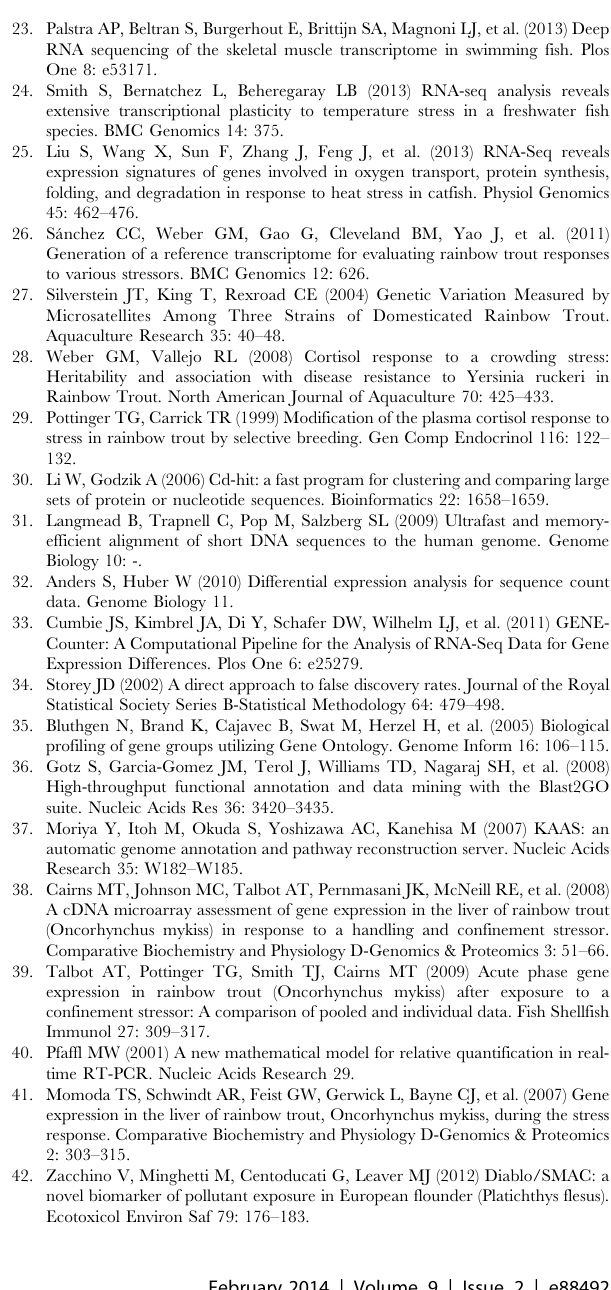
Figure S1 Comparison of normalized uniquely mapped reads among three runs. 1A, tank1; 1B, tank 2; 1C, tank 3, 1D, tank 4; and 1E, tank 5. Table S1 All 316 DETs in response to handling and confinement stress identified in this study. Table S2 Primers used for qPCR to validate transcript expression fold changes measured by